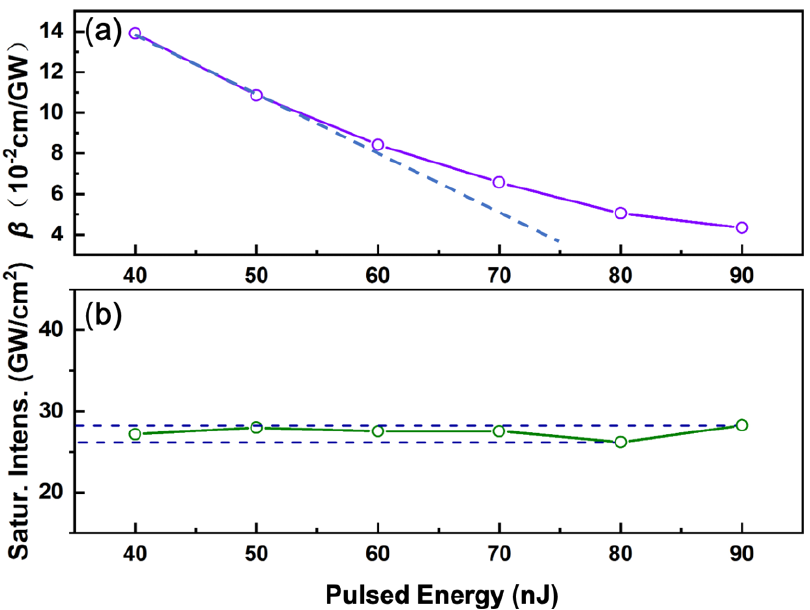
Figure 7. ( a ) Fitting values of nonlinear coefficient β and ( b ) saturation intensity as a function of the excitation pulsed energy.